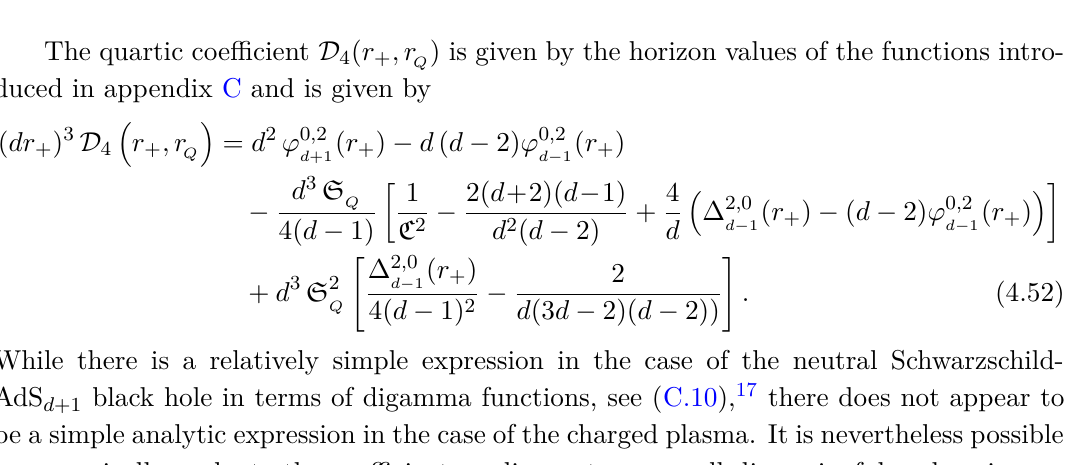
Figure 5 . The coefficient of the quartic term in the momentum diffusion dispersion relation given in (4.52). We have scaled out dimensions using the horizon radius r D 4 rescaled by a factor of ( dr + ) 3 . The additional dimension dependent factor makes the comparison to the neutral case in (C.10) straightforward since the is a relative factor of d between the horizon size and the boundary